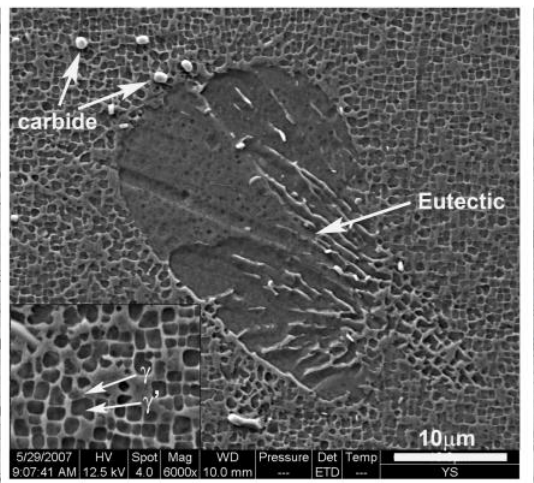
Figure 1. Typical microstructure of a single crystal superalloy under scanning electronic microscope, consisting of γ and γ ’ phases, carbides, and eutectic.